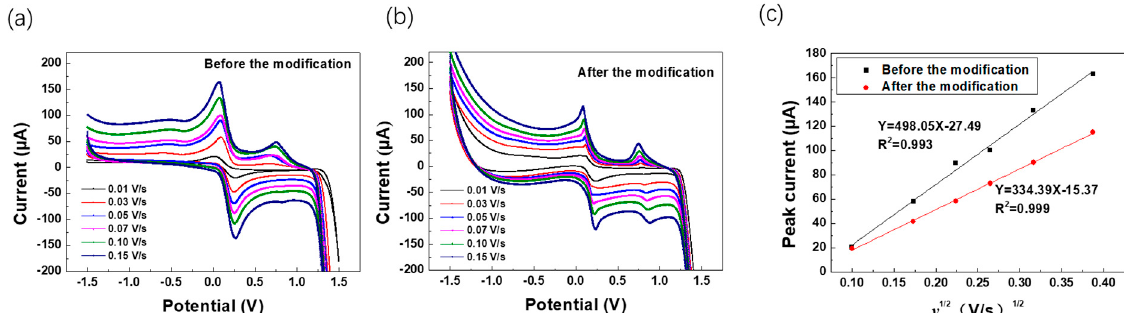
Figure 6. Comparison of the CV curves at different scan speeds. ( a ) CV curve of the unmodified electrodes at different scanning speeds in the KKS solution; ( b ) CV curve for WO 3 -modified electrodes at different scanning speeds in KKS solution; ( c ) Linear fitting curve of the oxidation peak current and v 1/2 before and after electrode modification at different scanning speeds.